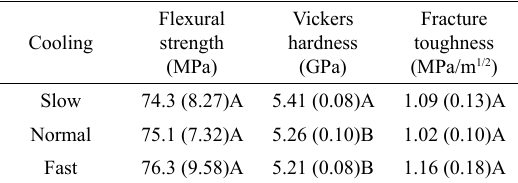
Table 2. Means of flexural strength, Vickers hardness and fracture toughness according to three different cooling methods. Flexural Cooling strength